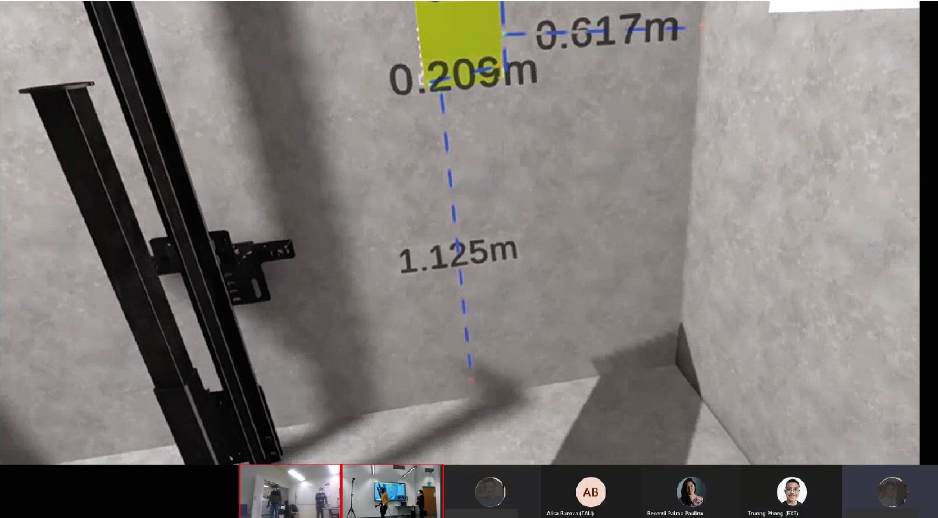
Figure 15. An HMDe participant’s point-of view and the two VR rooms shown via Teams (small images on the bottom left).